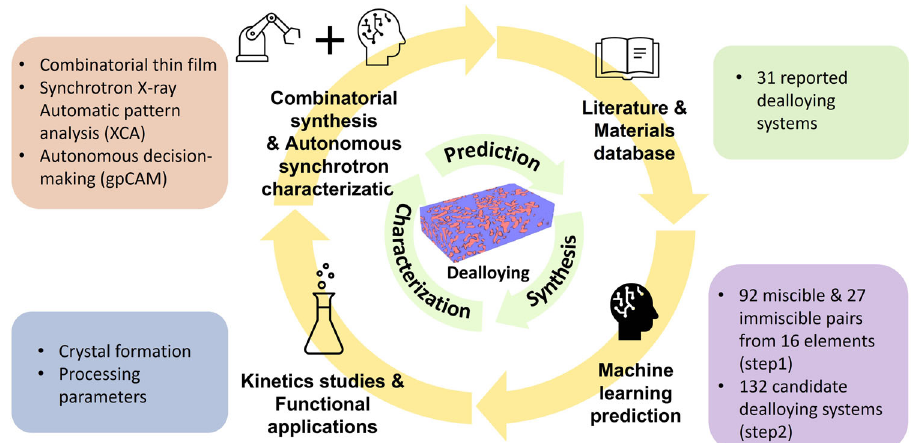
Fig. 1 Work fl ow of an ML-augmented framework to design SSID. The work fl ow includes the ML prediction of new ternary SSID systems (Xenonpy 76 , pymatgen 82 , matminer 77 , and literatures 78 ), combinatorial thin- fi lm deposition of predicted systems, and autonomous synchrotron X-ray characterization (XCA 50 , gpCAM 34 , and bluesky 81 libraries). The characterization result is returned to enrich the ML training datasets.